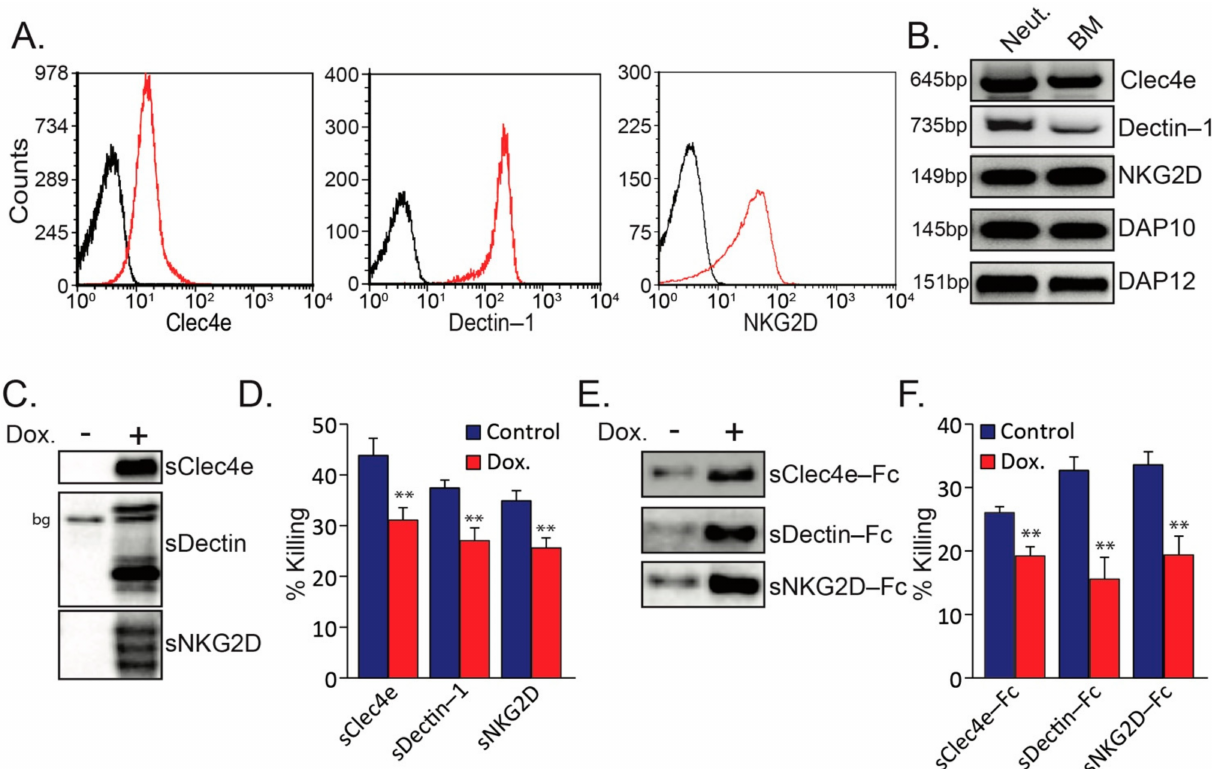
Figure 1. ( A ) Surface staining of tumor-elicited high-density neutrophils for Clec4e, Dectin-1 and NKG2D. ( B ) RT-PCR of indicted genes. Neut. = Neutrophils; BM = Bone marrow. ( C ) WB of supernatants from AT3 overexpressing tet-inducible form of Flag-tagged soluble sClec4e, sDectin and sNKG2D in the absence (Control) or presence of 1 µ g/mL doxycycline (Dox.). bg = background band. ( D ) The sensitivity of AT3 overexpressing tet-inducible form of soluble sClec4e-Flag, sDectin- Flag and sNKG2D-Flag to neutrophil cytotoxicity. ( E ) WB of supernatant from AT3 overexpressing tet-inducible form of soluble sClec4e-Fc, sDectin-1-Fc and sNKG2D-Fc in the absence (Control) or presence of 1 µ g/mL doxycycline (Dox.). ( F ) The sensitivity of AT3 overexpressing tet-inducible form of soluble sClec4e-Fc, sDectin-Fc and sNKG2D-Fc to neutrophil cytotoxicity. ** p <